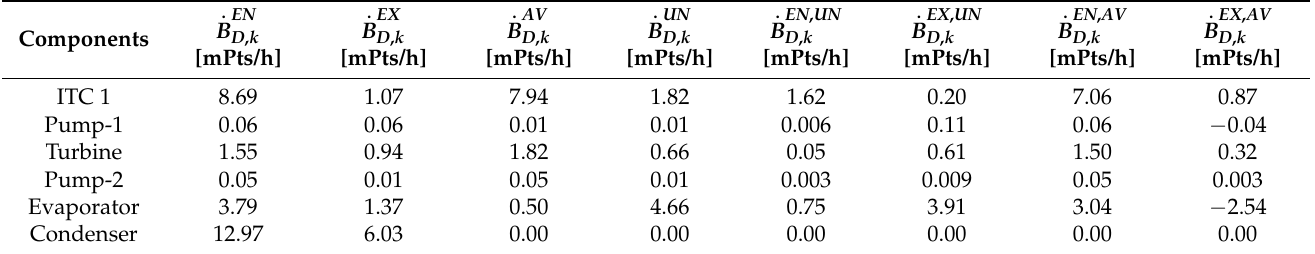
Table 18. Associated environmental impact by exergy on each component using aluminum as a material.